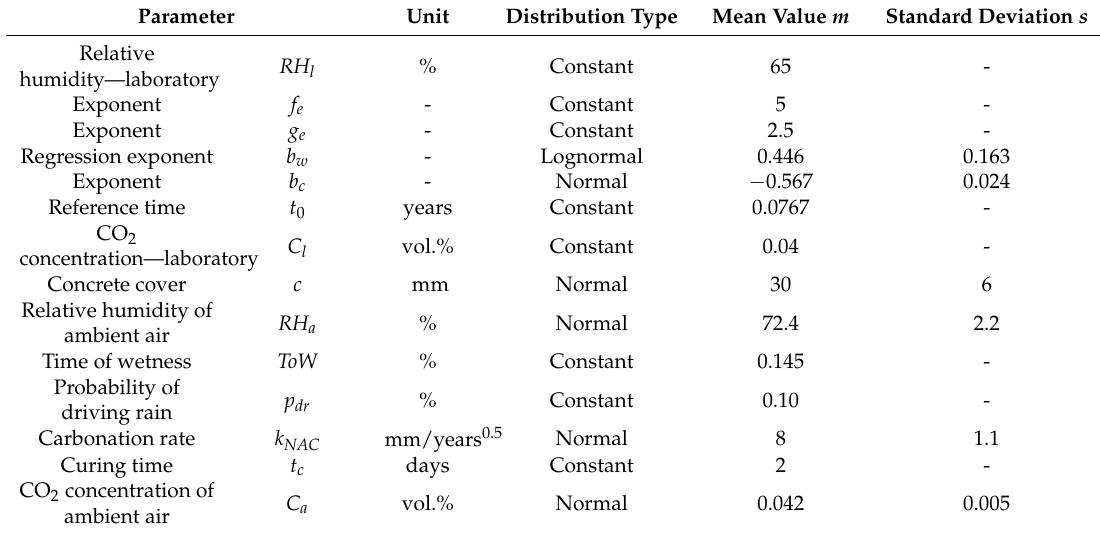
Table 14. Parameters of carbonation-induced depassivation for the wings of the Weikendorf